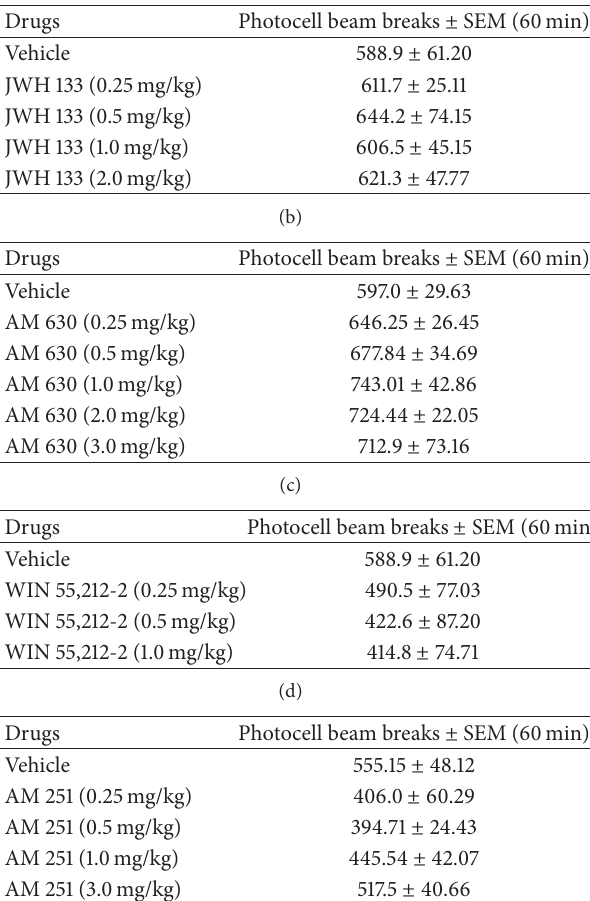
Table 1: Effects of CB2 receptor agonist, JWH 133 (a), CB2 receptor antagonist, AM 630 (b), CB1/CB2 receptor agonist, WIN 55,212-2 (c), and CB1 receptor antagonist, AM 251 (d), on the locomotor activity. The data are shown as the means ± SEM; photocell beam breaks of mice were measured immediately after injection for 60 min; 𝑛 = 8